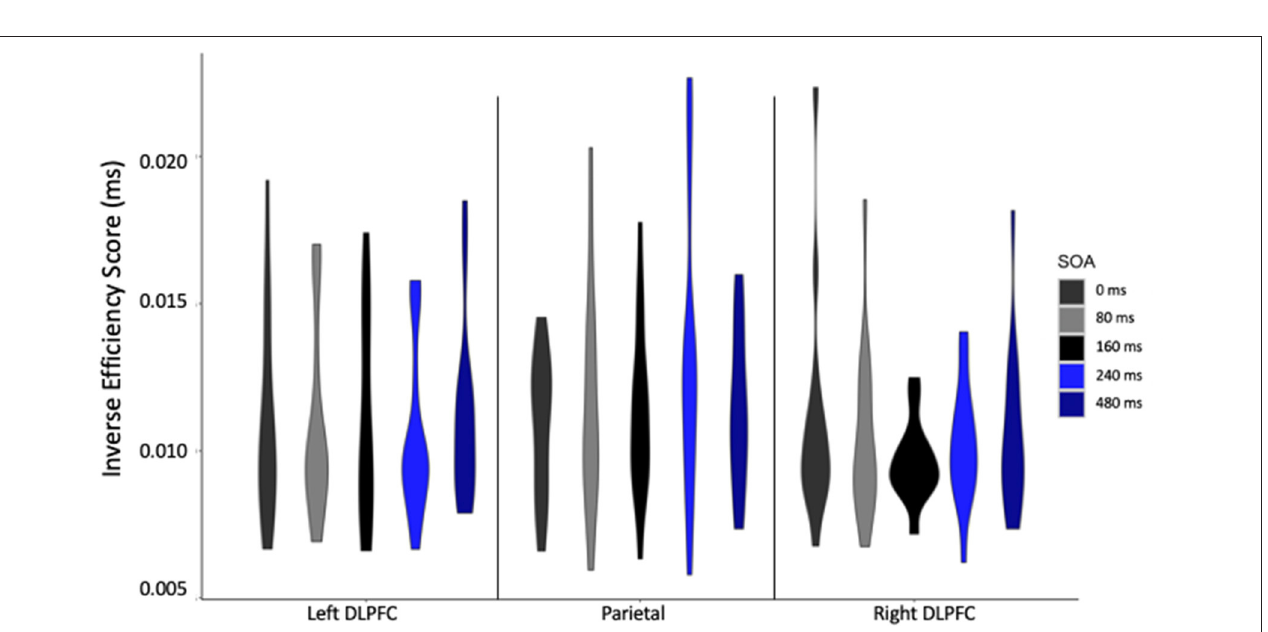
FIGURE 4 | Inverse efficiency score (IES) in milliseconds for each stimulation site, at each stimulus onset asynchrony (SOA) for Lie cards only.